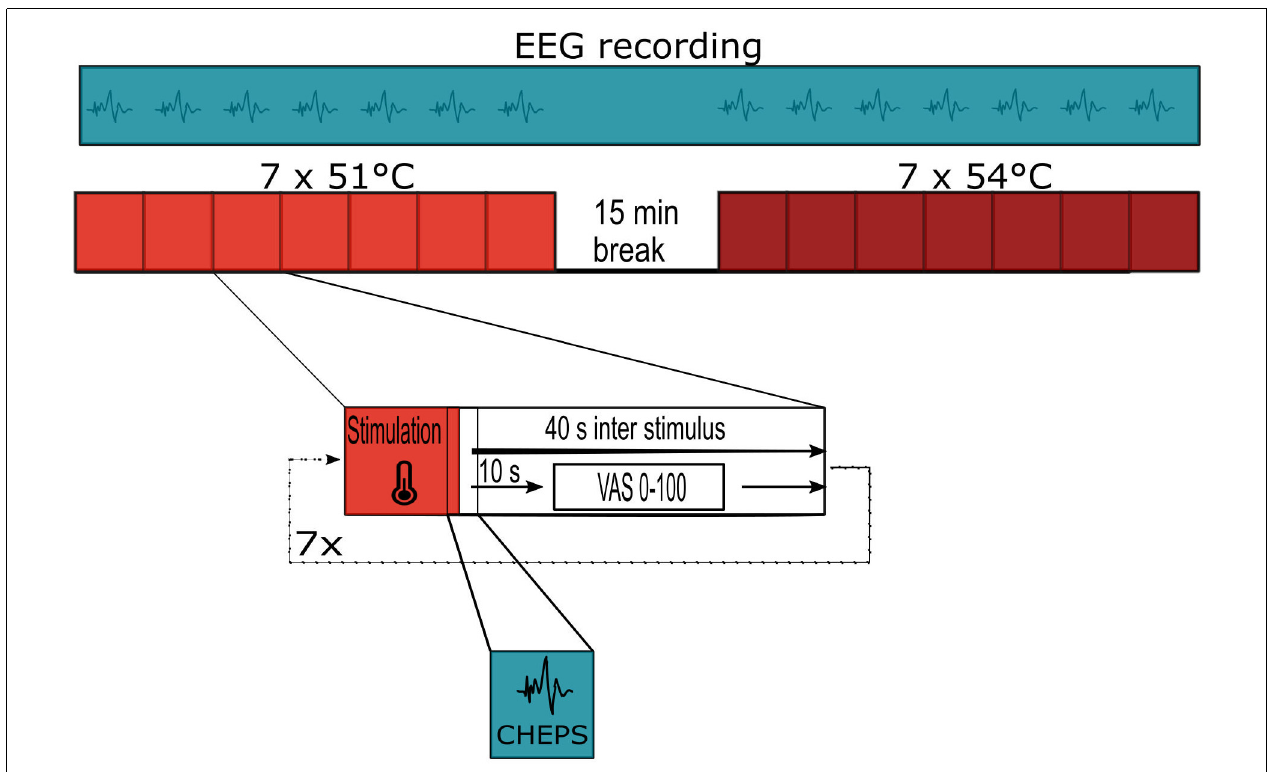
FIGURE 1 | Study flow and stimulation pattern for each